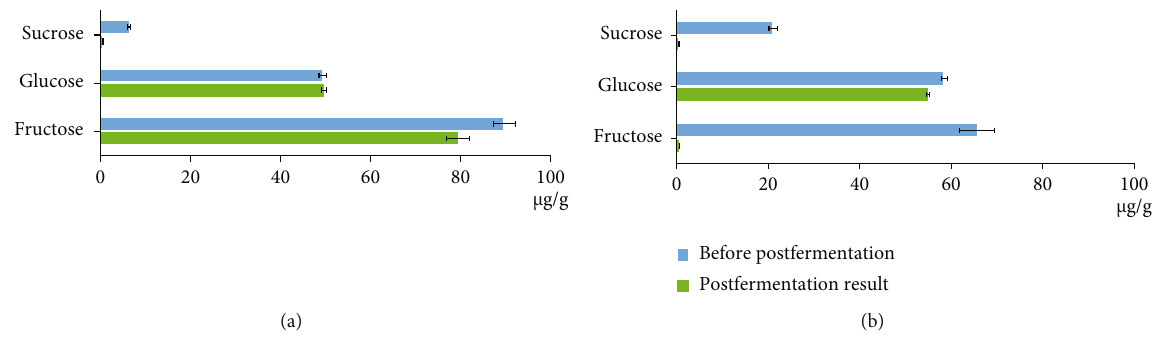
Figure 4: Impact of Eurotium cristatum INA 01267 postfermentation on the composition of sugars in herbal teas ( μ g/g). (a) Fireweed tea. (b) Apple tree leaf tea. Presented data of sugar content are mean values from 3 independentextractions ± standard deviation ð SD Þ